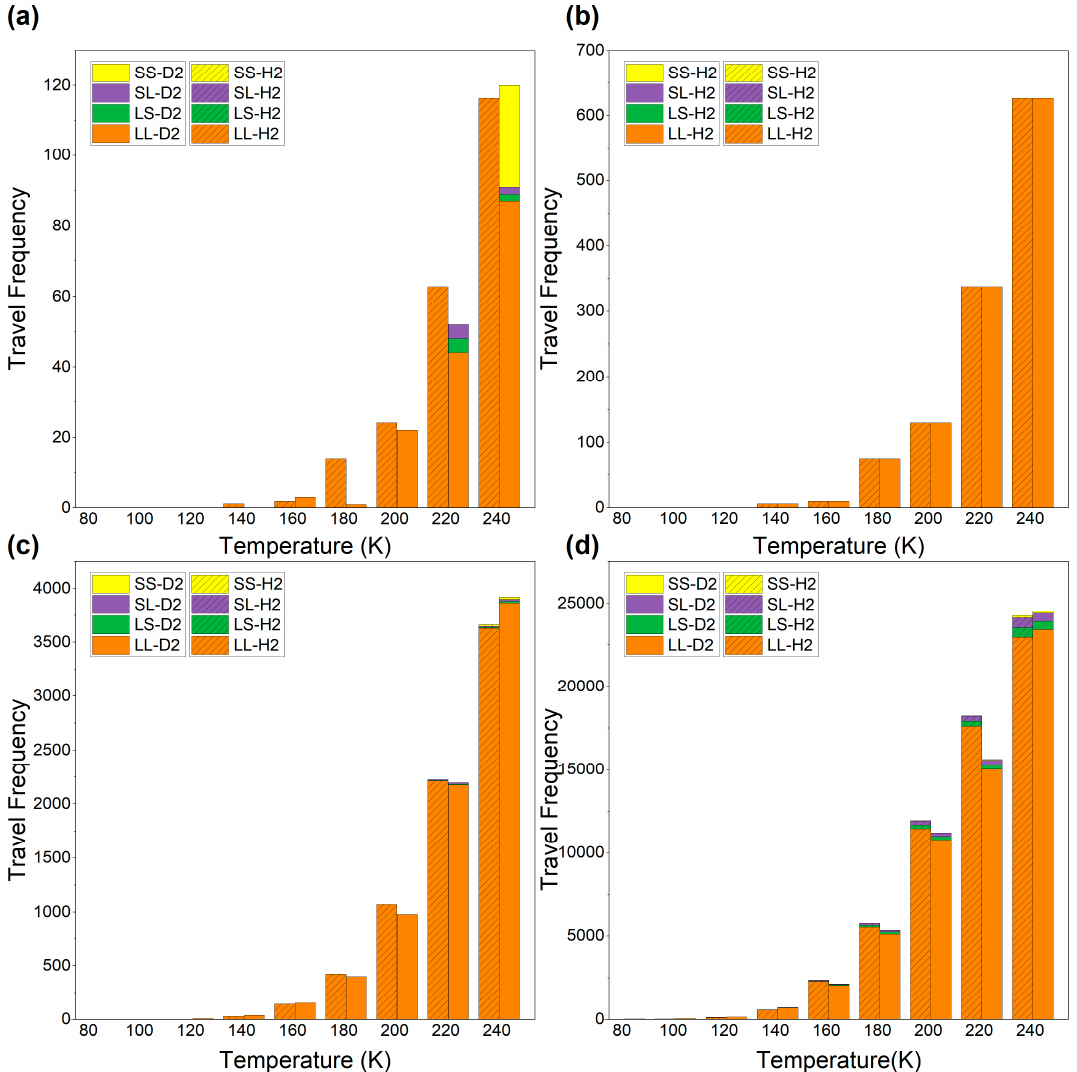
Figure 6. The inter-cage hopping with respect to the temperature. The results of the different systems—1-occupancy ( a ), 2-occupancy ( b ), 3-occupancy ( c ) and 4-occupancy ( d )—for the model with H 2 molecules as the guests are reported with solid colours, and hashed colours were used to present the results for the D 2 -containing model. The diffusion between two large cages or between small cages is labelled as LL and SS, respectively. The diffusion from a large cage to a small cage, and from a small cage to a large cage is labelled as LS and SL, respectively.